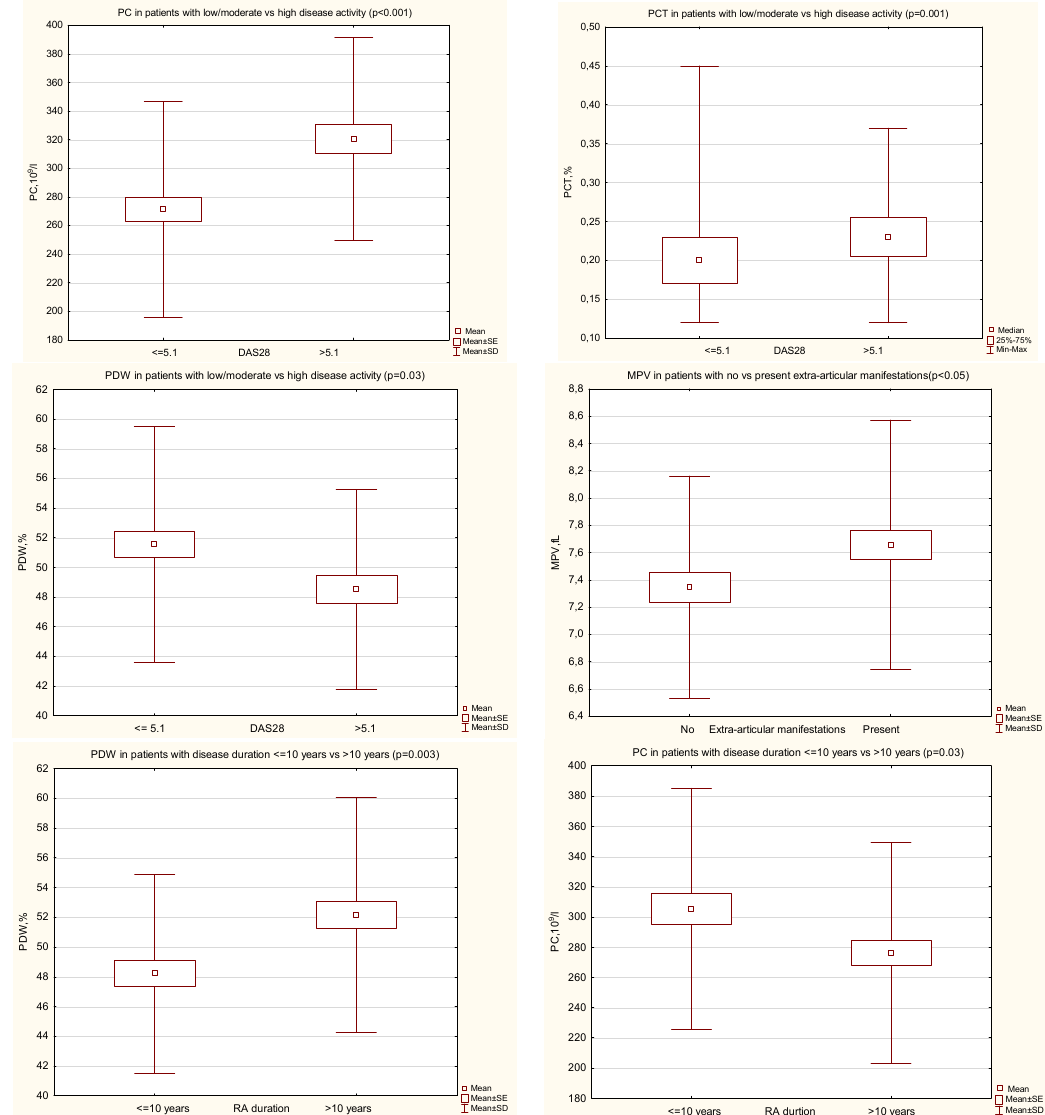
Figure 1. Significant differences of PIs in certain groups of patients with RA. DAS28, disease activity score in 28 joints; MPV, mean platelet volume; PC, platelet count; PCT, plateletcrit; PDW, platelet distribution width; RA, rheumatoid